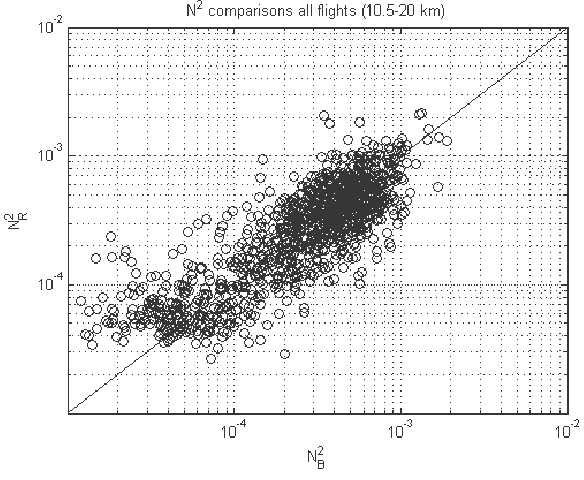
Fig. 7. Comparisons of N 2 r and N 2 between 10.5 and 20km.